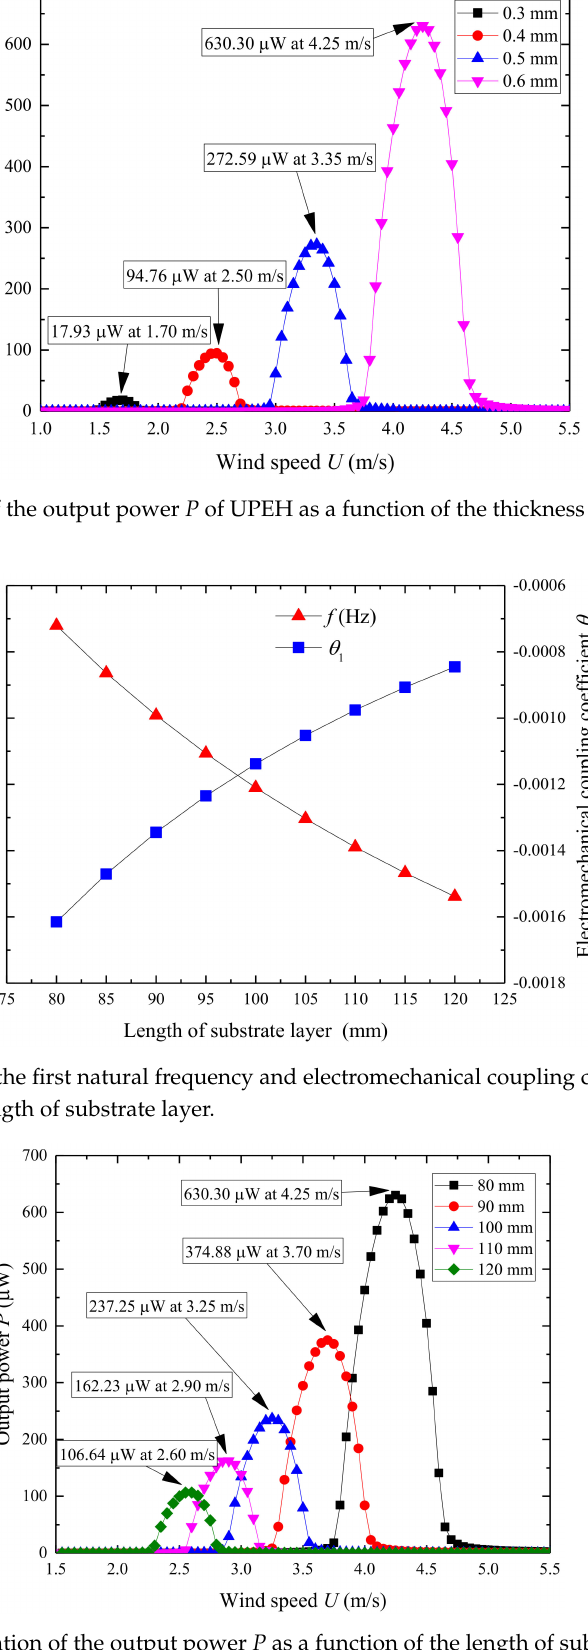
Figure 10. Variation of the output power P as a function of the length of substrate